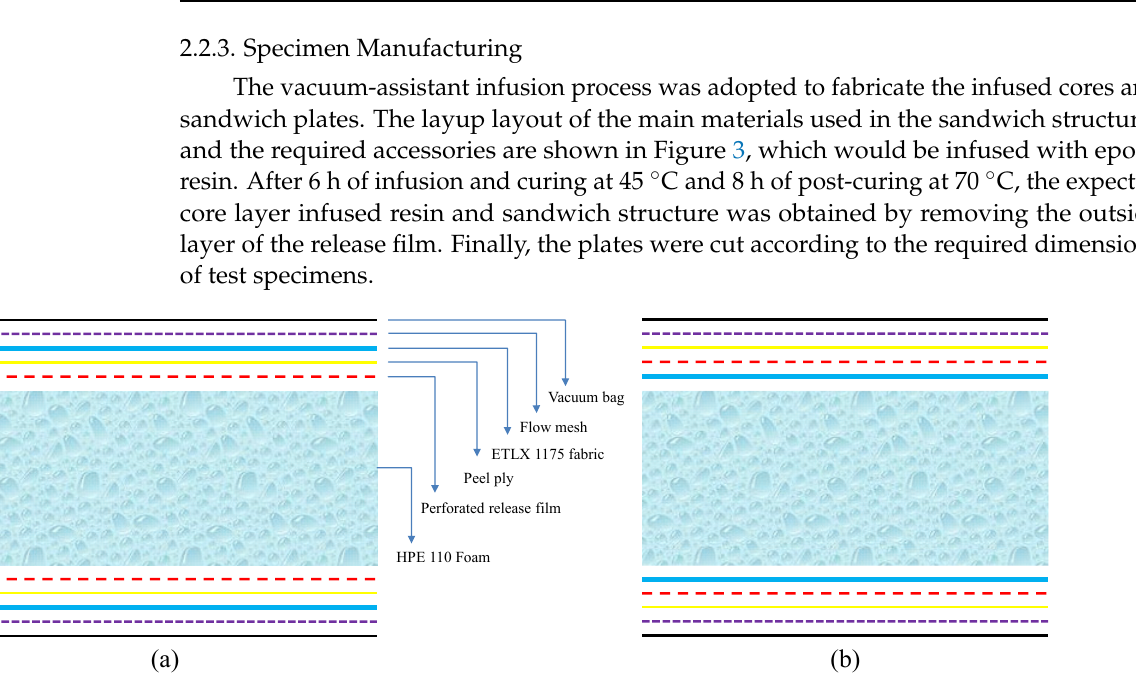
Table 2. The dimensions of the test specimens.